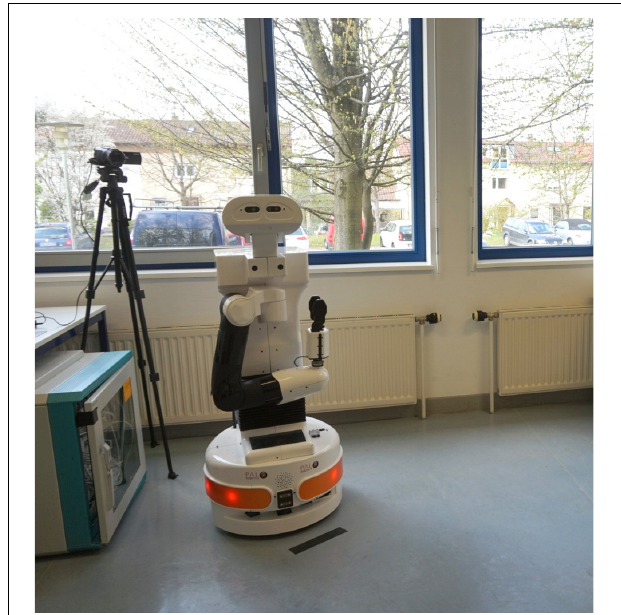
FIGURE 2 | Investigated humanoid robot (TIAGo, PAL Robotics) in initial position with retracted